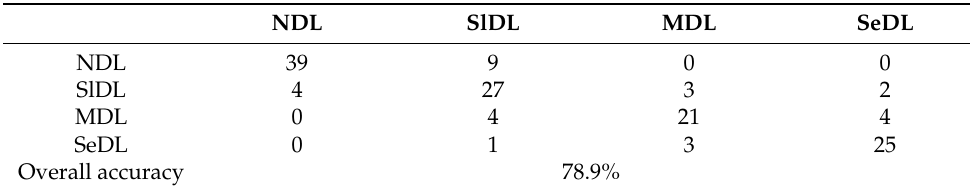
Table 5. Classification accuracy of